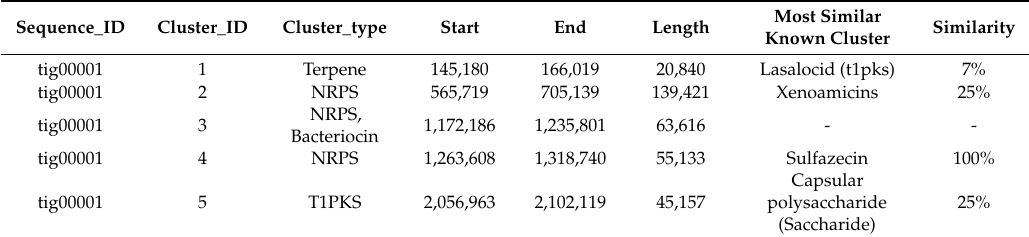
Table 2. Prediction of secondary metabolism gene